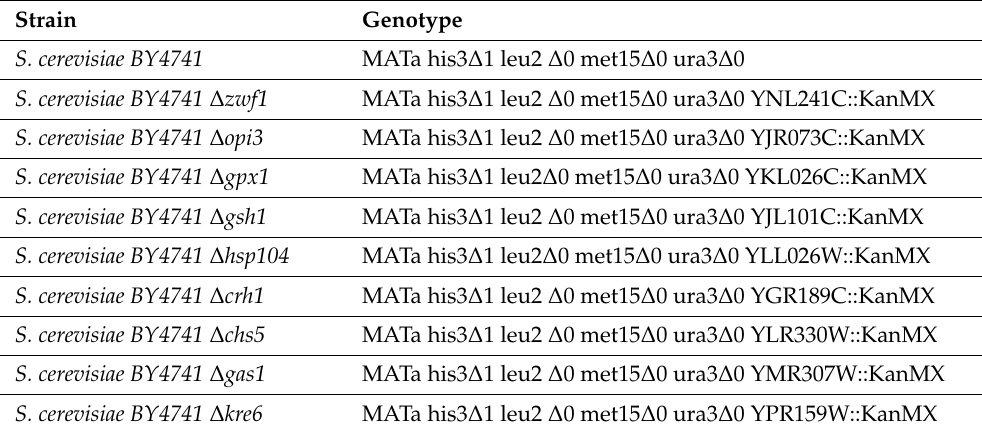
Table 1. Yeast strains used in this